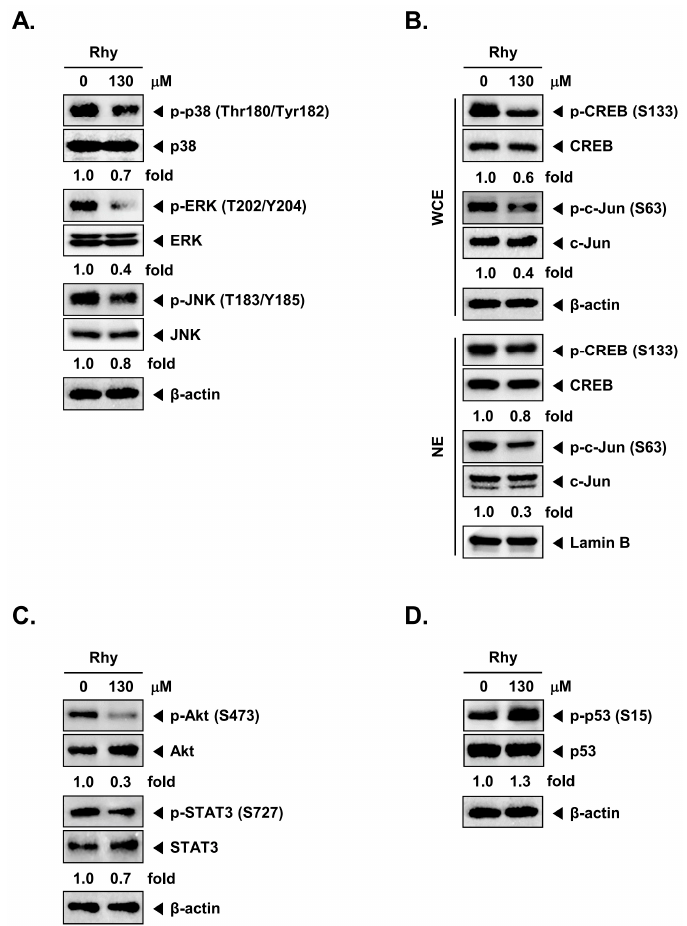
Figure 5. Effect of Rhy on various signal transduction pathways. ( A ) HepG2 cells (1 × 10 6 cells/well) were incubated with Rhy (130 µ M) for 12 h. Whole-cell extracts were prepared, and 20 µ g of the whole-cell lysate was resolved by sodium dodecyl sulfate polyacrylamide gelelectrophoresis, electrotransferred to nitrocellulose membrane, sliced from the membrane based on the molecular weight, and then probed with antibodies against p-p38, p38, p-ERK, ERK, p-JNK, and JNK as described in Materials and Methods. The same blots were stripped and reprobed with β -actin antibody to verify equal protein loading. The results shown here are representative of three independent experiments; ( B ) HepG2 cells (1 × 10 6 cells/well) were treated with Rhy (130 µ M) for 12 h. After that, whole-cell extracts and nuclear proteins were extract were equal amounts of lysates were analyzed by Western blot analysis using antibodies against p-CREB, CREB, p-c-Jun, and c-Jun. The same blots were stripped and reprobed with β -actin and Lamin B antibody to verify equal protein loading. The results shown here are representative of three independent experiments; ( C ) HepG2 cells (1 × 10 6 cells/well) were incubated with Rhy (130 µ M) for 12 h. Whole-cell extracts were prepared, and 20 µ g of the whole-cell lysate was resolved by sodium dodecyl sulfate polyacrylamide gelelectrophoresis, electrotransferred to nitrocellulose membrane, sliced from the membrane based on the molecular weight, and then probed with antibodies against p-Akt, Akt, p-STAT3, and STAT3 as described in Materials and Methods. The same blots were stripped and reprobed with β -actin antibody to verify equal protein loading. The results shown here are representative of three independent experiments; ( D ) HepG2 cells (1 × 10 6 cells/well) were incubated with Rhy (130 µ M) for 12 h. Whole-cell extracts were prepared, and 20 µ g of the whole-cell lysate was resolved by sodium dodecyl sulfate polyacrylamide gelelectrophoresis, electrotransferred to nitrocellulose membrane, sliced from the membrane based on the molecular weight, and then probed with antibodies against p-p53, and p53 as described in Materials and Methods. The same blots were stripped and reprobed with β -actin antibody to verify equal protein loading.